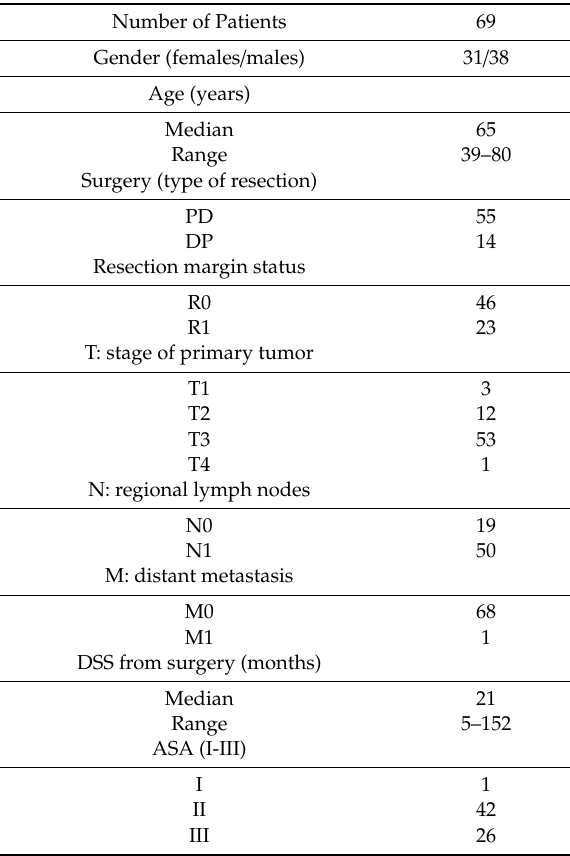
Table 1. Clinical–pathological characteristics of